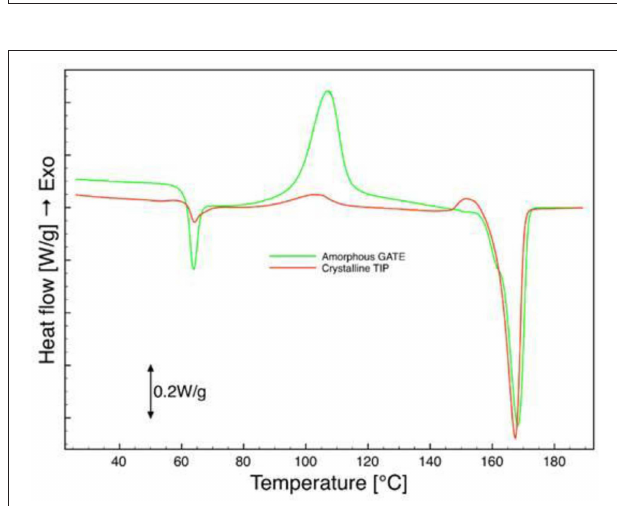
FIGURE 7 | DSC analysis of micro-injected biphasic PLA sample (amorphous gate, crystalline tip), first